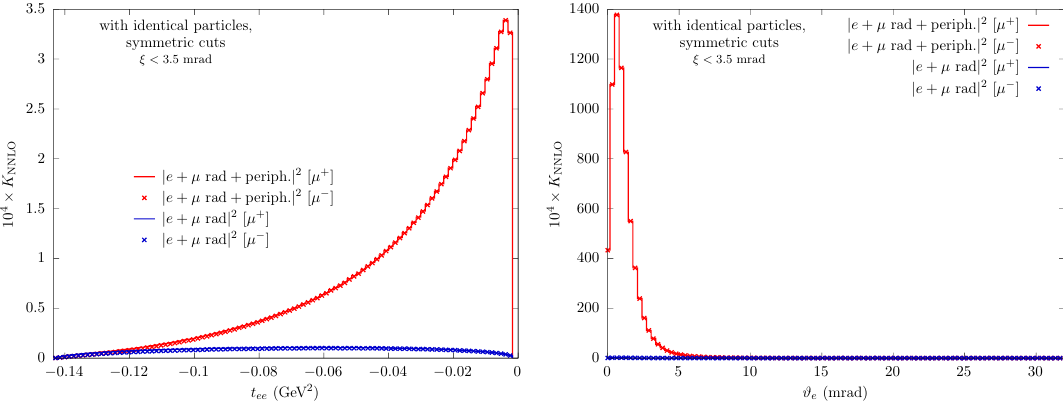
Figure 21. Left: differential K NNLO factor on t ee distribution for real e + e − radiation with realistic event selection, with acoplanarity cut. Right: the same for θ